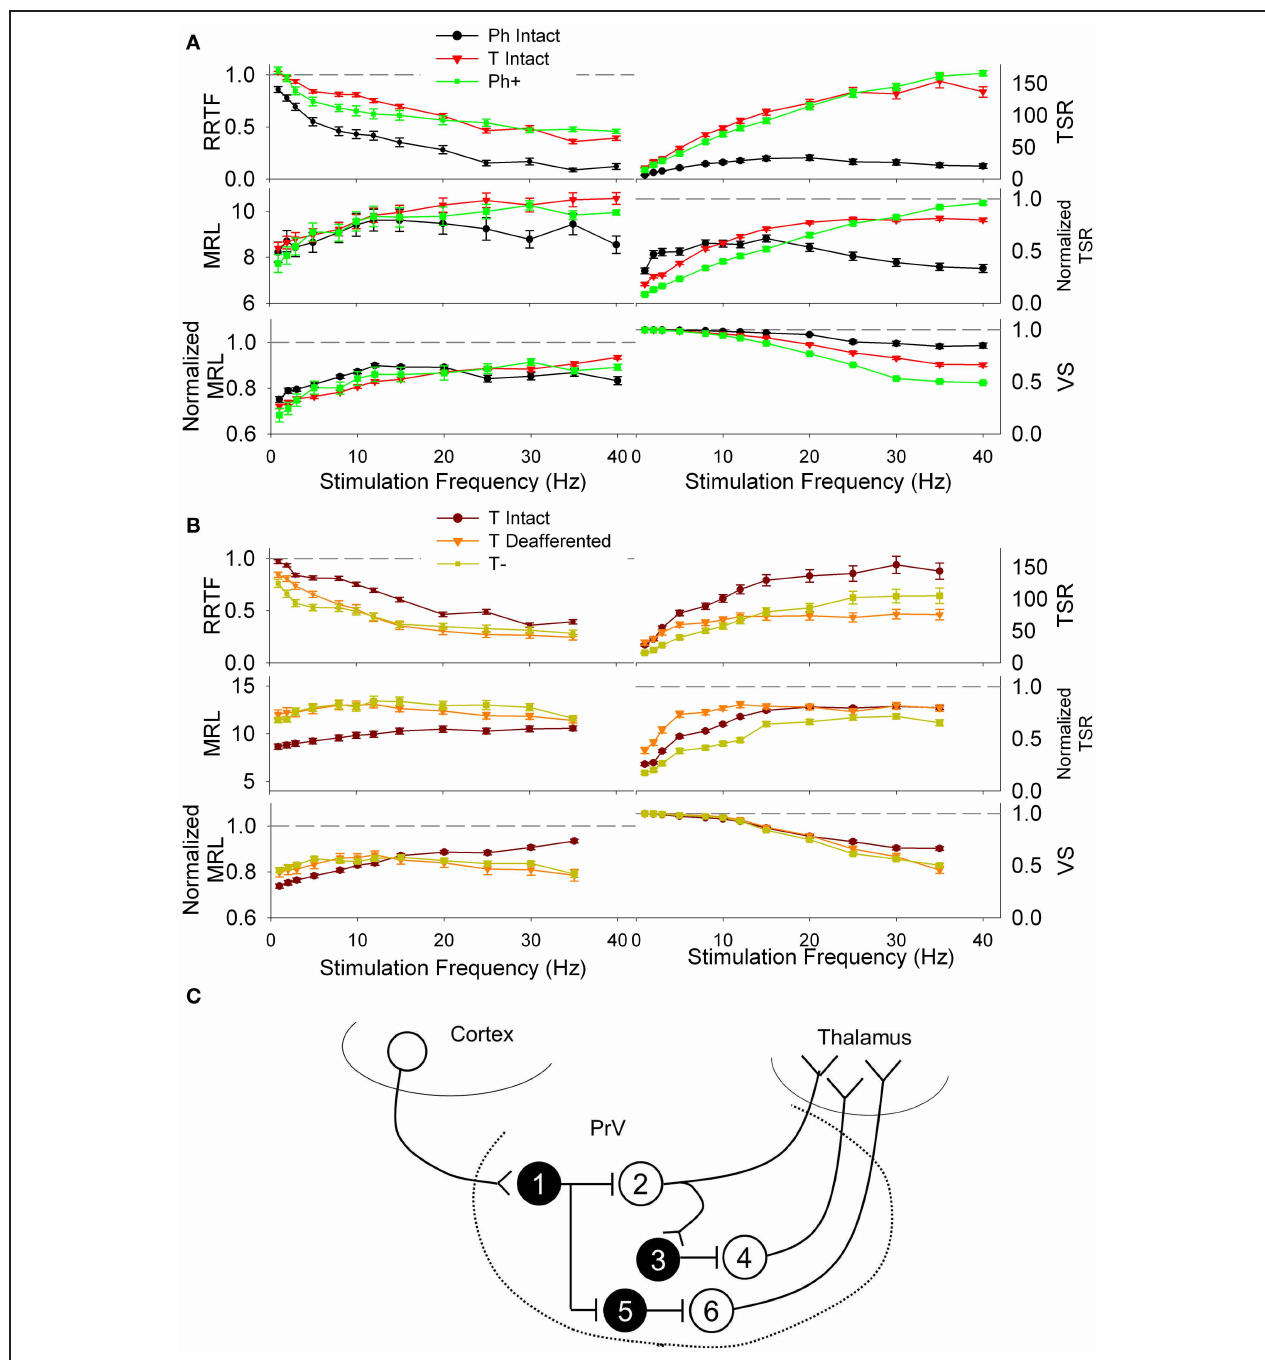
state, suggesting they could be tonic neurons that fire phasically due to an excitatory action of the corticotrigeminal projections (neurons 4 and 6 in the scheme below). (C) Schematic representation of possible PrV intranuclear connections and cortical input determining tonic and phasic responses of the trigeminal neurons shown in (A) and (B) . Black filled, inhibitory interneurons (numbered 1, 3, and 5); white filled (neurons 2, 4, and 6), thalamic projecting tonic neurons responding phasically under the influence of the cortical input and tonically after decortication (neuron 2) or tonically under normal conditions and being inhibited after removal of the sensorimotor cortex (neurons 4 and